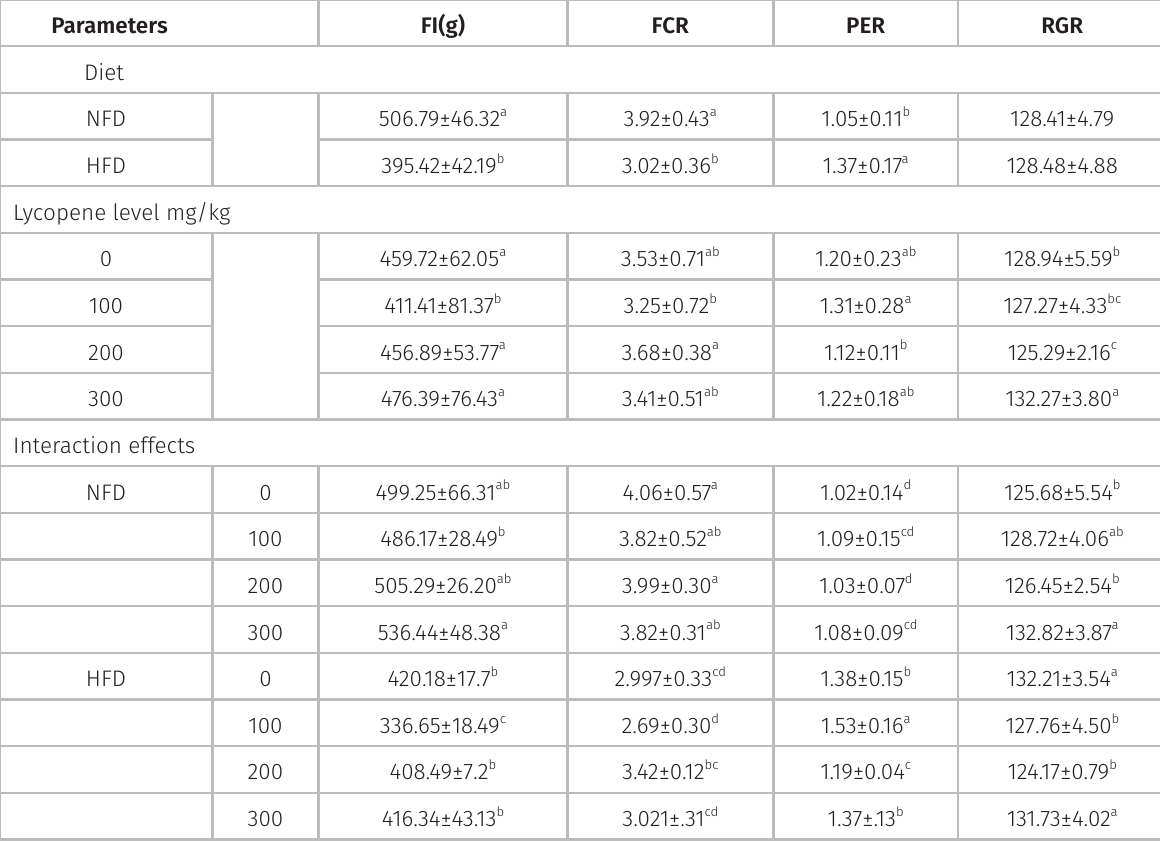
Table III. Effects of graded levels of lycopene supplementation to normal fat diet (NFD) and high-fat diet (HFD) on FI, FCR, PER and RGR of growing Japanese